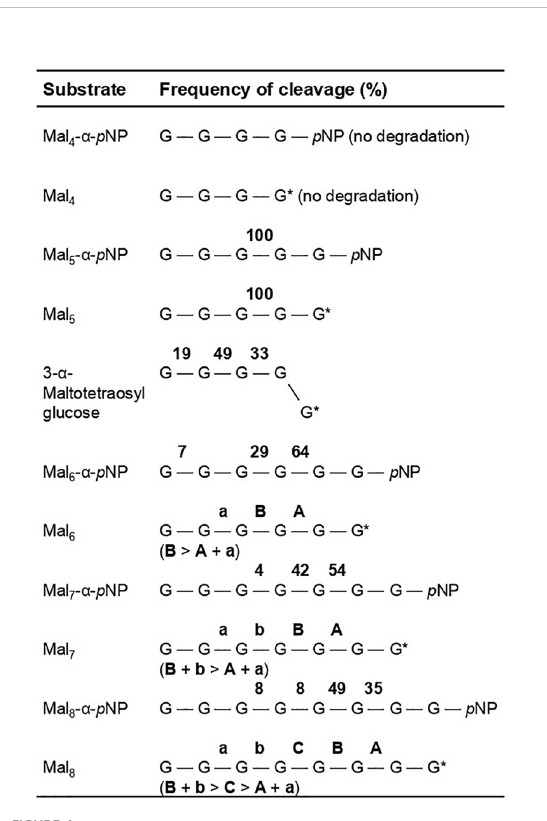
FIGURE 4 Frequency of site-speci fi c cleavage during rAoAgtA-catalyzed degradation of maltooligosaccharides and their derivatives. The values in bold are the cleavage frequencies of glycosidic linkages. The cleavage positions that could not be distinguished are indicated as “ a and A ” or “ b or B ” . G, glucose residue; p NP, p -nitrophenly group; G*, glucose residue with a reducing